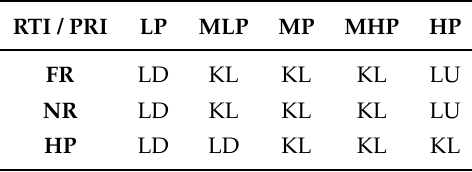
Table 4. The rule table for the Change Level